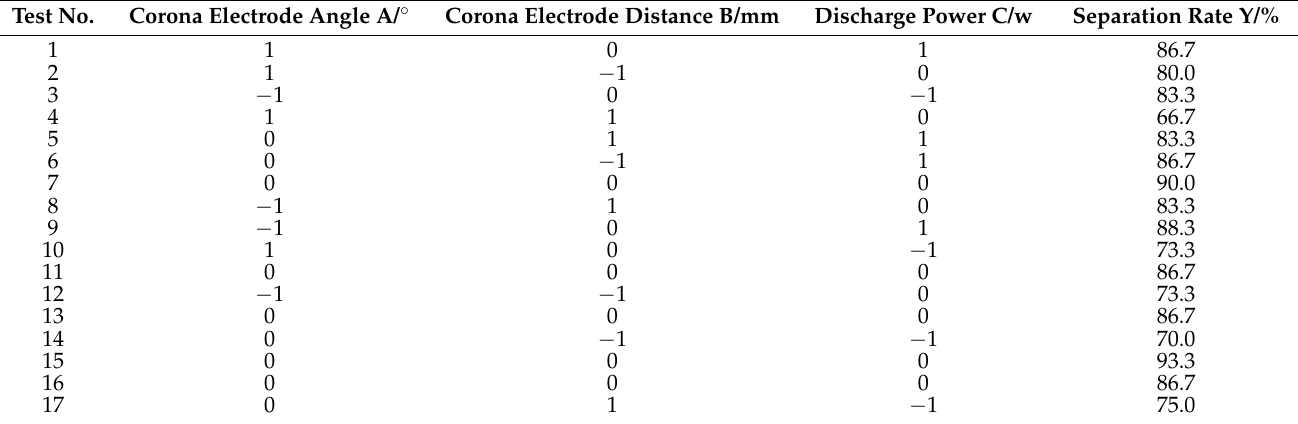
Table 3. Results of the response surface